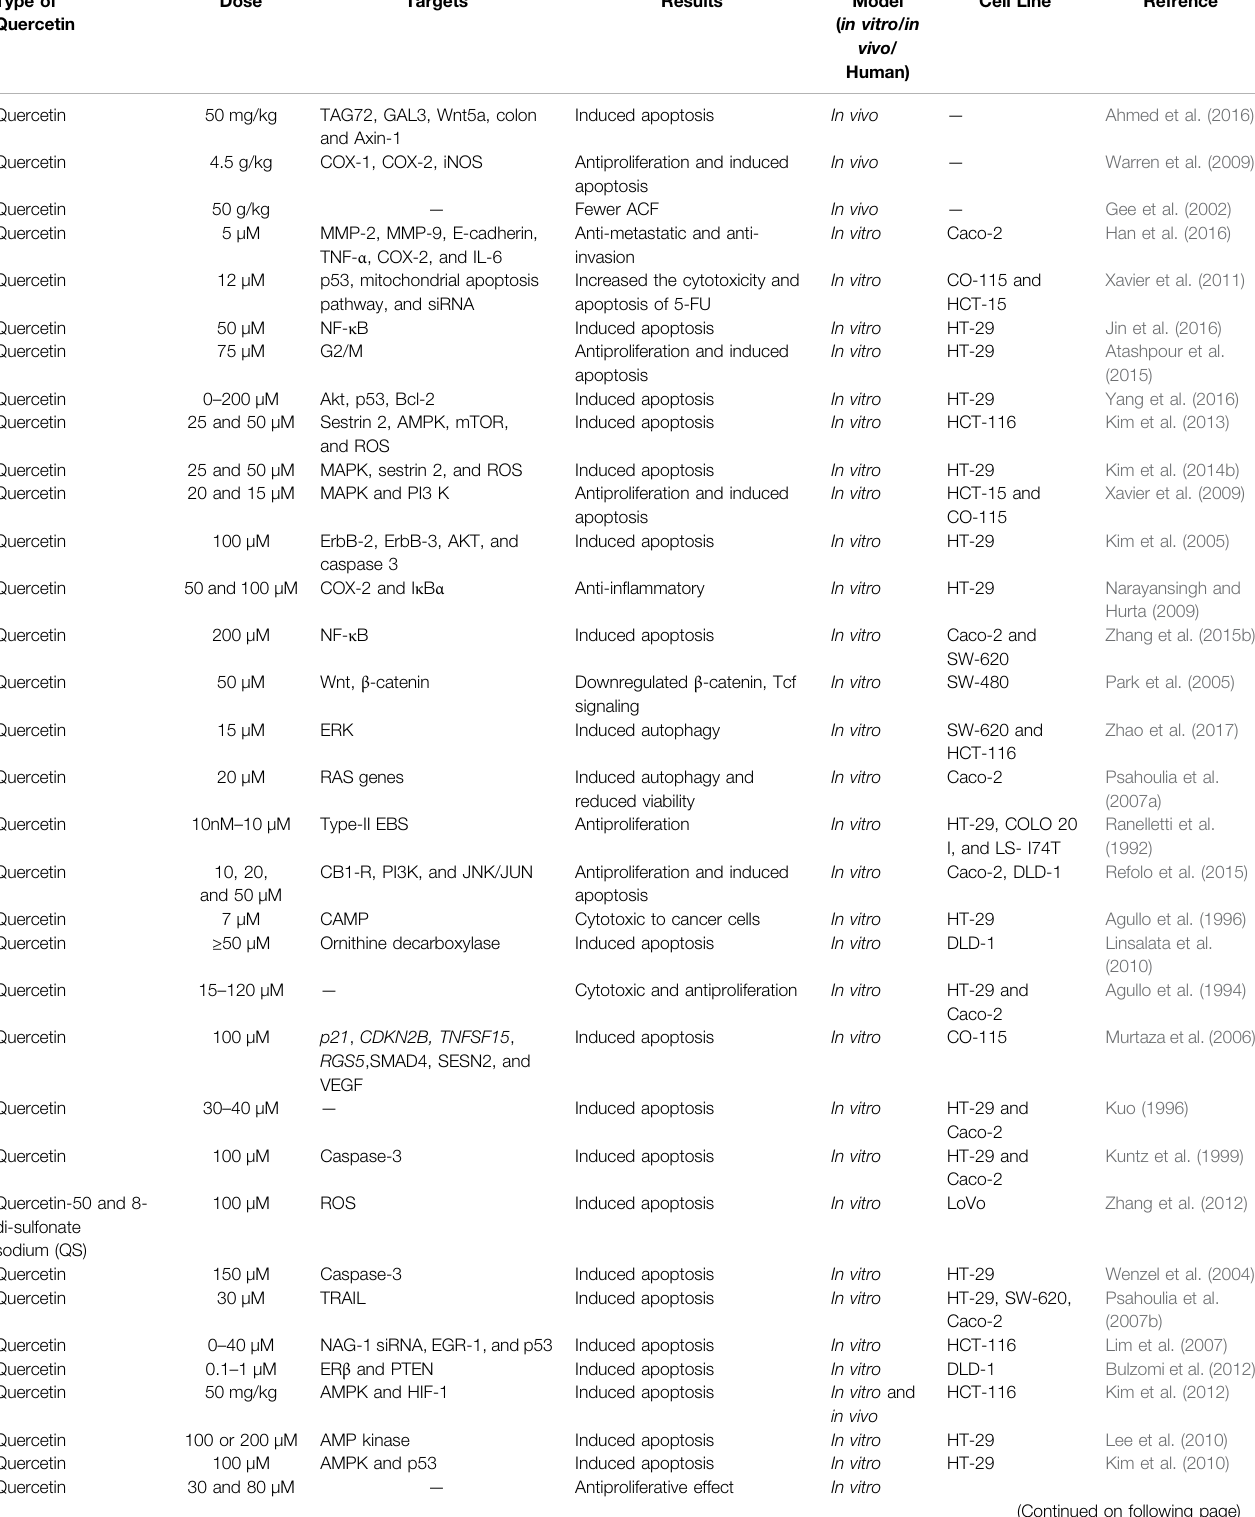
TABLE 3 | Studies on the therapeutic effects of quercetin in colorectal